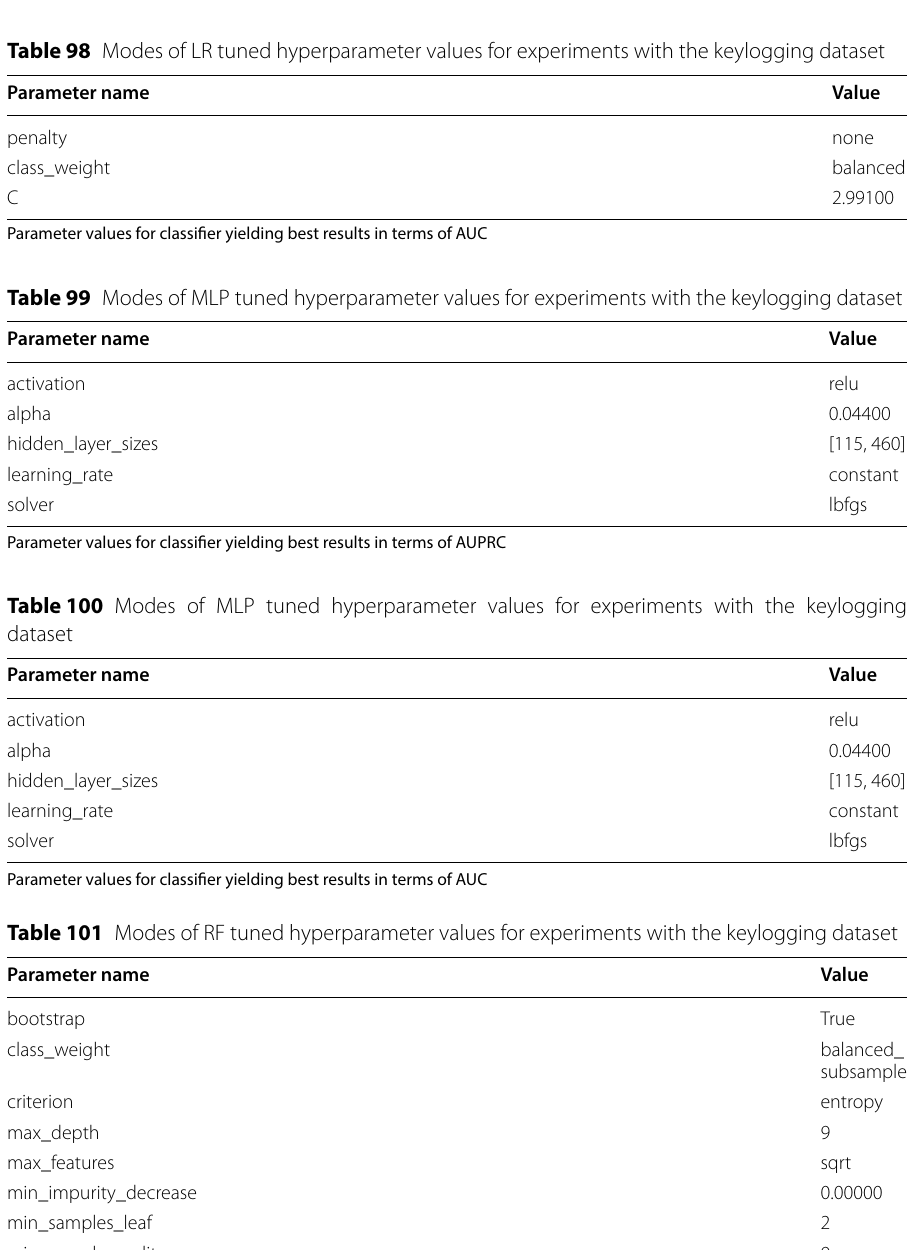
Parameter values for classifier yielding best results in terms of